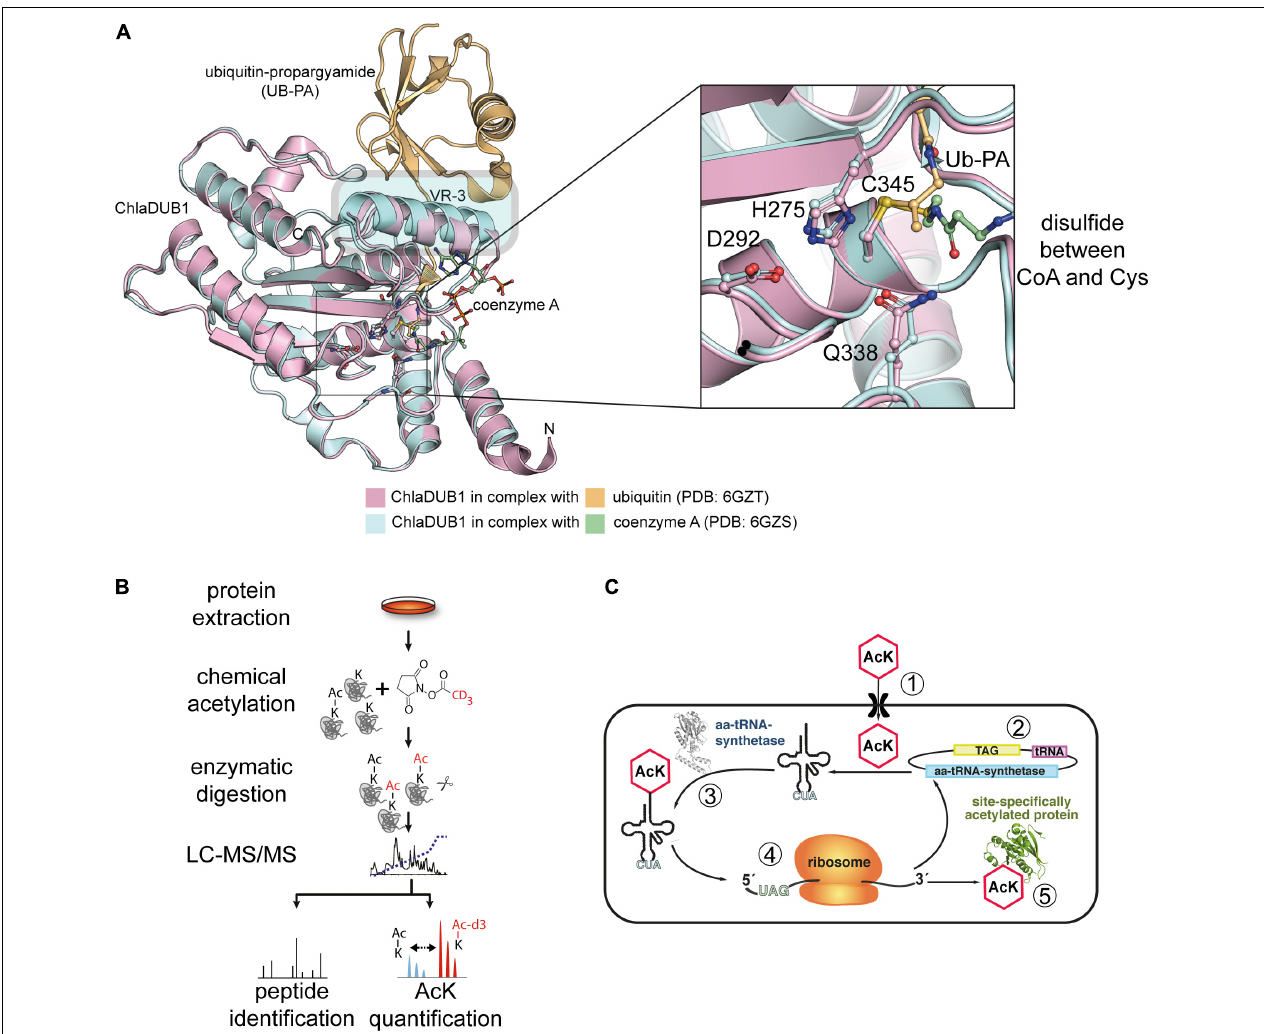
FIGURE 8 | CE-clan related bacterial virulence factors with dual deubiquitinase (DUB)- and acetyltransferase (AcT)- activity and technological advances to study lysine ac(et)ylation. (A) Structure of the catalytic domain of Chlamydia trachomatis ChlaDUB1 (PDB: 6GZT; PDB: 6GZS). ChlaDUB1 was shown to act as DUB with specificity for K63-linked ubiquitin chains and as acetyltransferase for lysine, threonine and serine side chains. To discriminate this activity from lysine acetyltransferase activity, the abbreviation AcT is used. Notably, both activities, namely a deubiquitination, i.e., a hydrolysis reaction, and the transfer of an acetyl-group, i.e., a condensation reaction, is catalyzed by the same active site. The enzyme is a CE-clan related protease using a catalytic triad (order: His-Asp-Cys) for catalysis. Mutational studies showed that mutation of the catalytic cysteine to alanine (ChlaDUB1: C345A) abolished both activities. In contrast to other CE-clan related virulence factors that only are active as DUB or AcT, ChlaDUB1 contains an α -helix (VR-3: variable region-3) that mediates binding toward ubiquitin or acetyl-CoA/CoA using different surfaces. The structure with ubiquitin was obtained by using a ubiquitin activity-based probe ubiquitin-propargylamide (Ub-PA), resulting in covalent linkage of the Ub-PA to the active site Cys. Coenzyme A (CoA) was also covalently bound by formation of a disulfide bond between the CoA cysteamine and the active site Cys [the figure was generated with PyMOL v.2.3.4 (Schrödinger LLC, 2000)]. (B) Improved mass-spectrometry workflows to obtain information of the lysine ac(ety)lation stoichiometry on a systemic scale. Initially, mass-spectrometry was used to identify lysine acetylation sites in proteins without obtaining information on the dynamics or stoichiometry. Workflows that were developed, such as SILAC, allow to systemically compare alterations in lysine ac(et)ylation in diverse cellular states. Finally, chemical labeling of all lysine side chains (and N-terminal amino groups) in proteins (before enzymatic digestion) using isotopically labeled molecules such as N-acetoxy-succinimide or acetic-anhydride allows to perform absolute quantification of ac(et)ylation on a global scale. This workflow can be combined with SILAC and internal standards to generate powerful workflows to assess the kinetics and stoichiometry of ac(et)ylation. (C) Genetically encoding N-( ε )-ac(et)yl-lysine in proteins using the genetic code expansion concept (GCEC). By applying an orthogonal and synthetically evolved ac(et)yl-lysyl-tRNA (AcKRS)/tRNA CUA pair based on the pyrrolysyl-tRNA CUA (PylRS)/PylT pair from Methanosarcina barkeri or M. mazei acetyl-L-lysine and other lysine acylations, such as, propionyl-, butyryl-, crotonyl-lysine can be site-specifically incorporated into any protein as response to an amber stop codon. The system is orthogonal in all used model organisms. (1) Cells are fed with acetyl-L-lysine, deacetylases can be inhibited by addition of selected deacetylase inhibitors, (2) cells express the evolved AcKRS/tRNA CUA pair, (3) AcKRS charges the cognate amber suppressor tRNA CUA with the ac(et)yl-lysine, (4) Ac(et)yl-lysine is co-translationally incorporated into proteins as response to an amber stop codon using the host cells translation machinery. Using this technology enables to obtain natively-folded and quantitatively lysine ac(et)ylated proteins for structural and functional studies [figure modified from Lammers et al. (2019) and Blasl et al. (2021)].